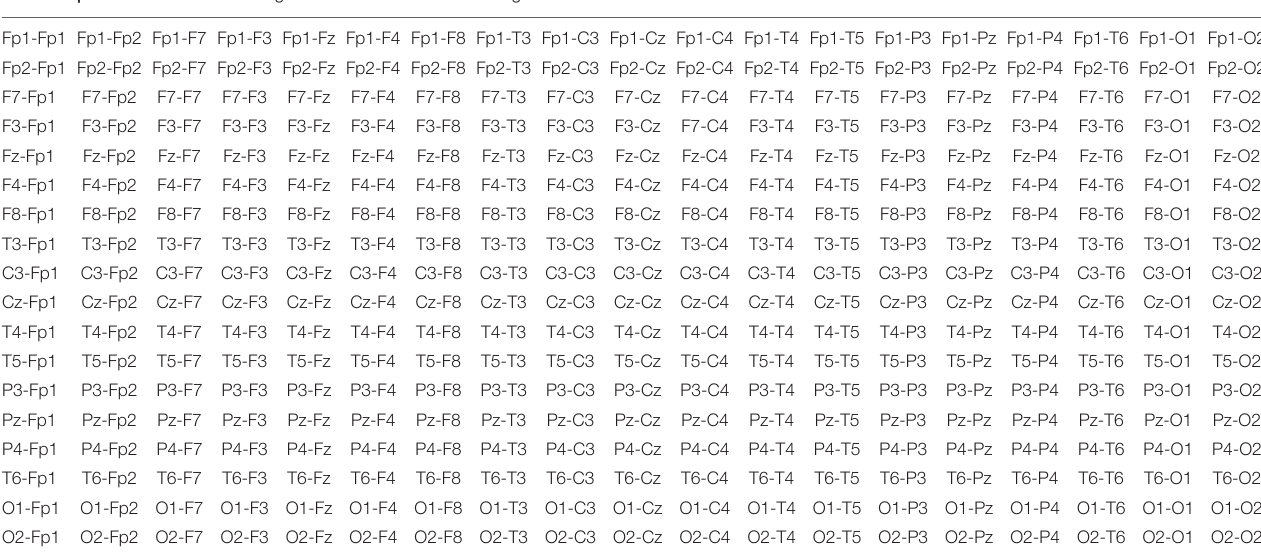
TABLE 1 | A 19 × 19 table consisting of the difference of the EEG signals between two